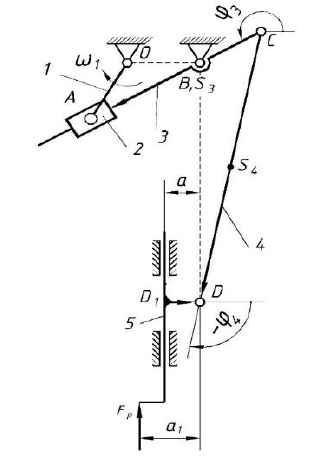
Fig.1. Structural scheme of the